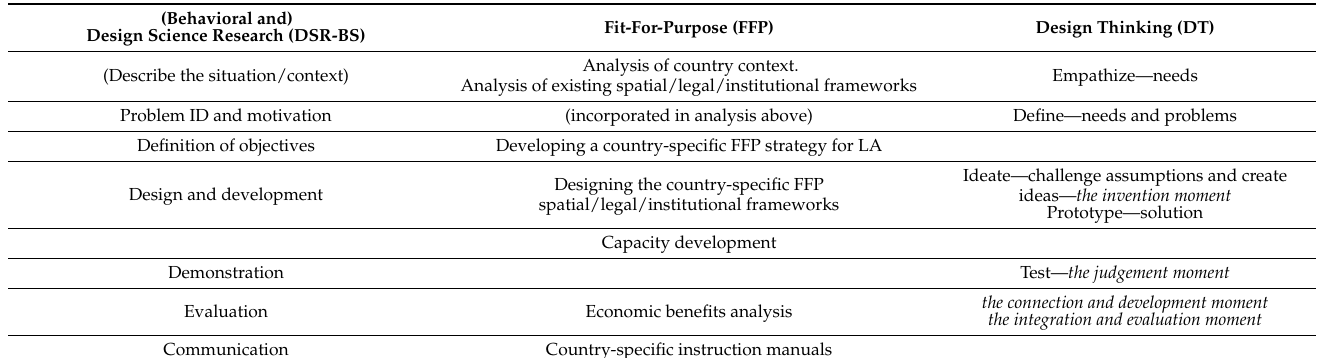
Table 3. Thematic framework: the DSR-BS, FFP, and DT